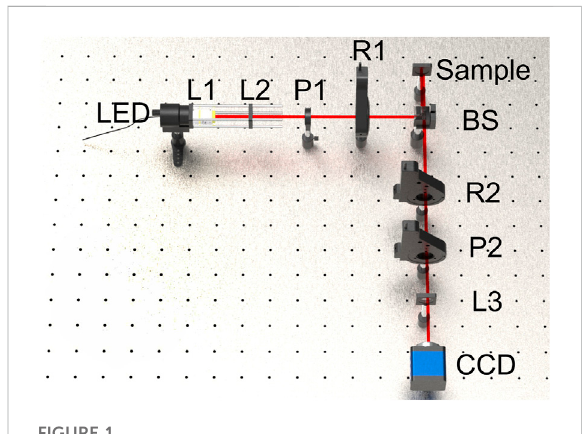
FIGURE 1 Optical path diagram of the collinear backscattering Mueller matrix imaging